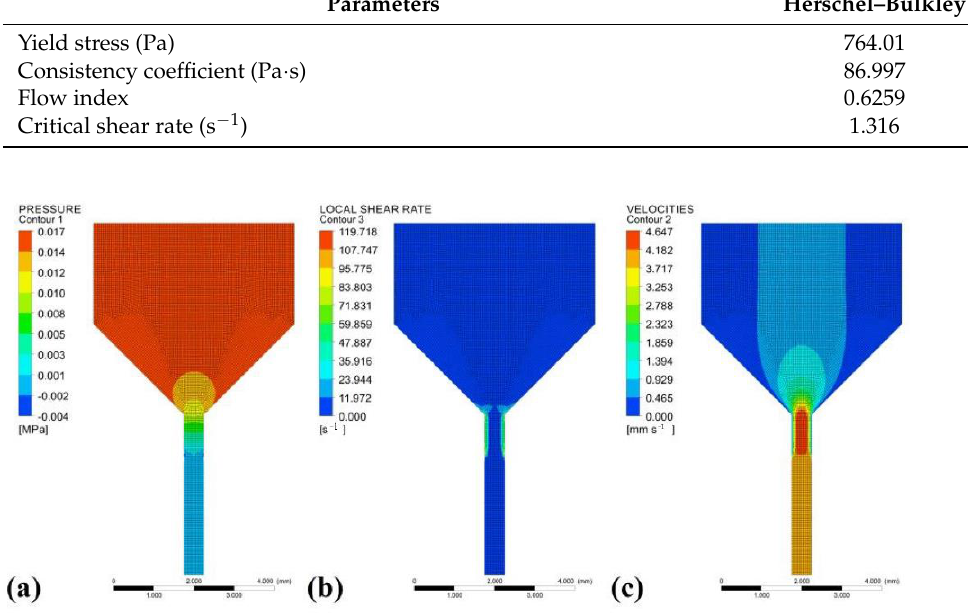
Figure 4. Results of fluid simulation: ( a ) pressure distribution; ( b ) shear rate distribution; ( c ) velocity distribution.